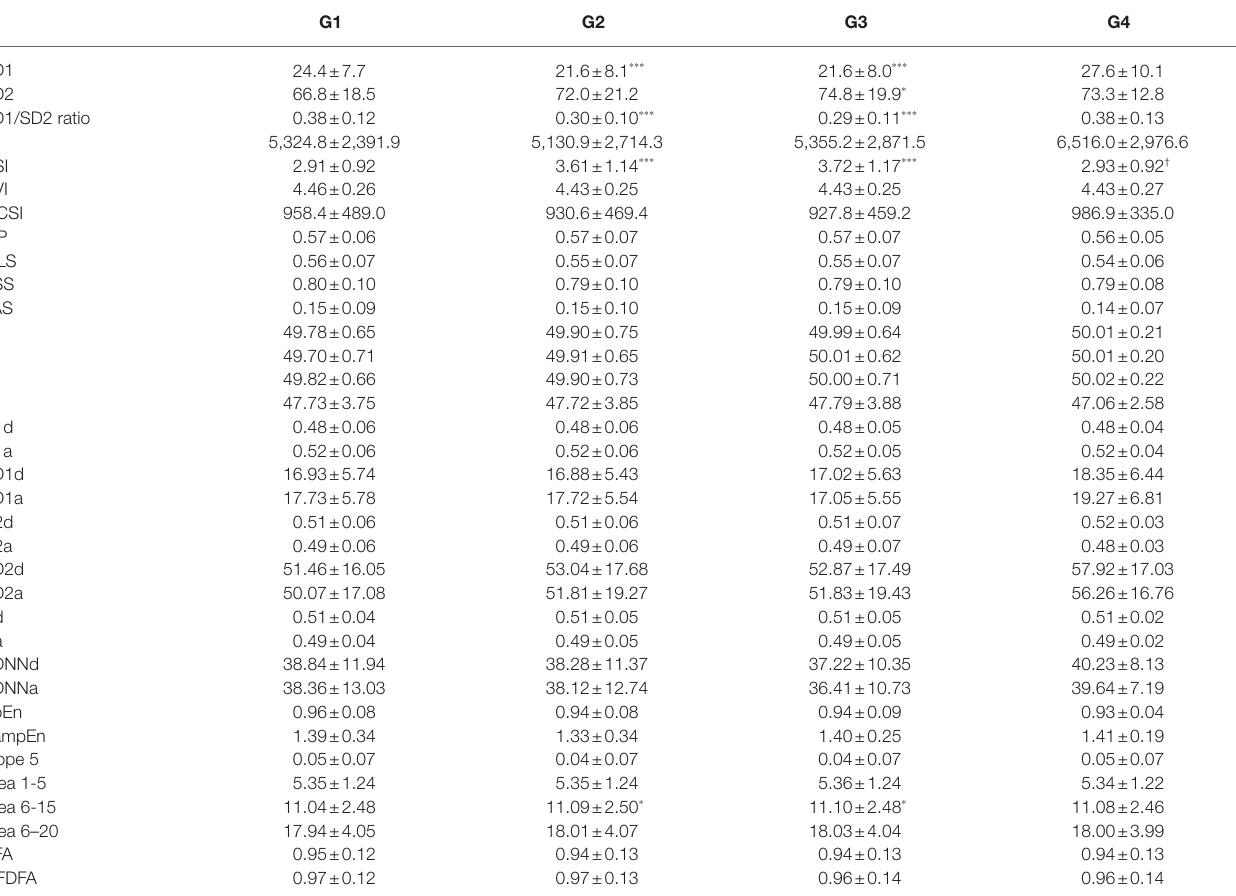
TABLE 5 | HRV non-linear features (absolute values are means ±